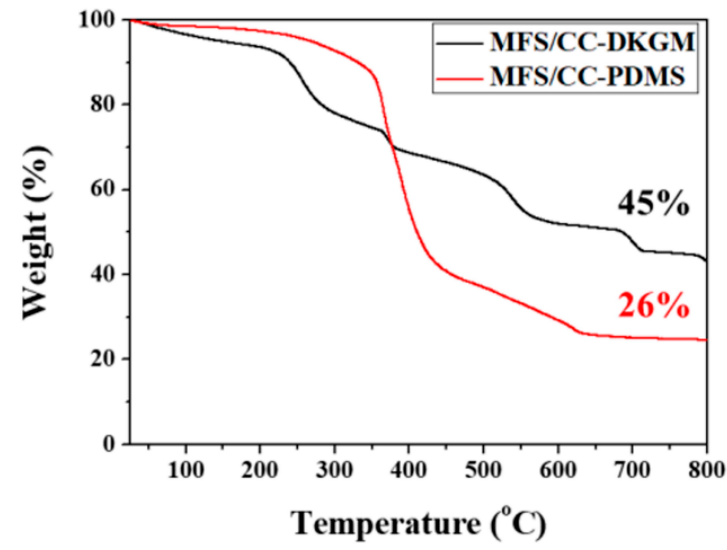
Figure 7. TGA data for the MFS/CC-DKGM and MFS/CC-PDMS after the oil/water separation test.